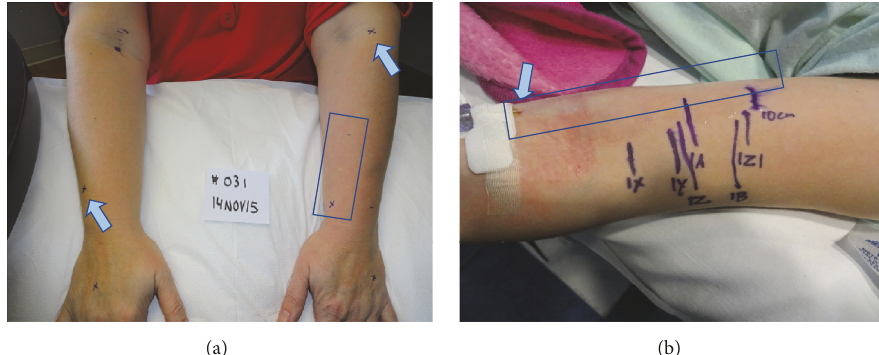
Figure 2: (a) Adult study patient with marked hypothetical insertion sites (arrow) and interrogated segments (box) and (b) pediatric study patient with PIV (arrow) and marked ultrasound findings in 10 cm segment (box).